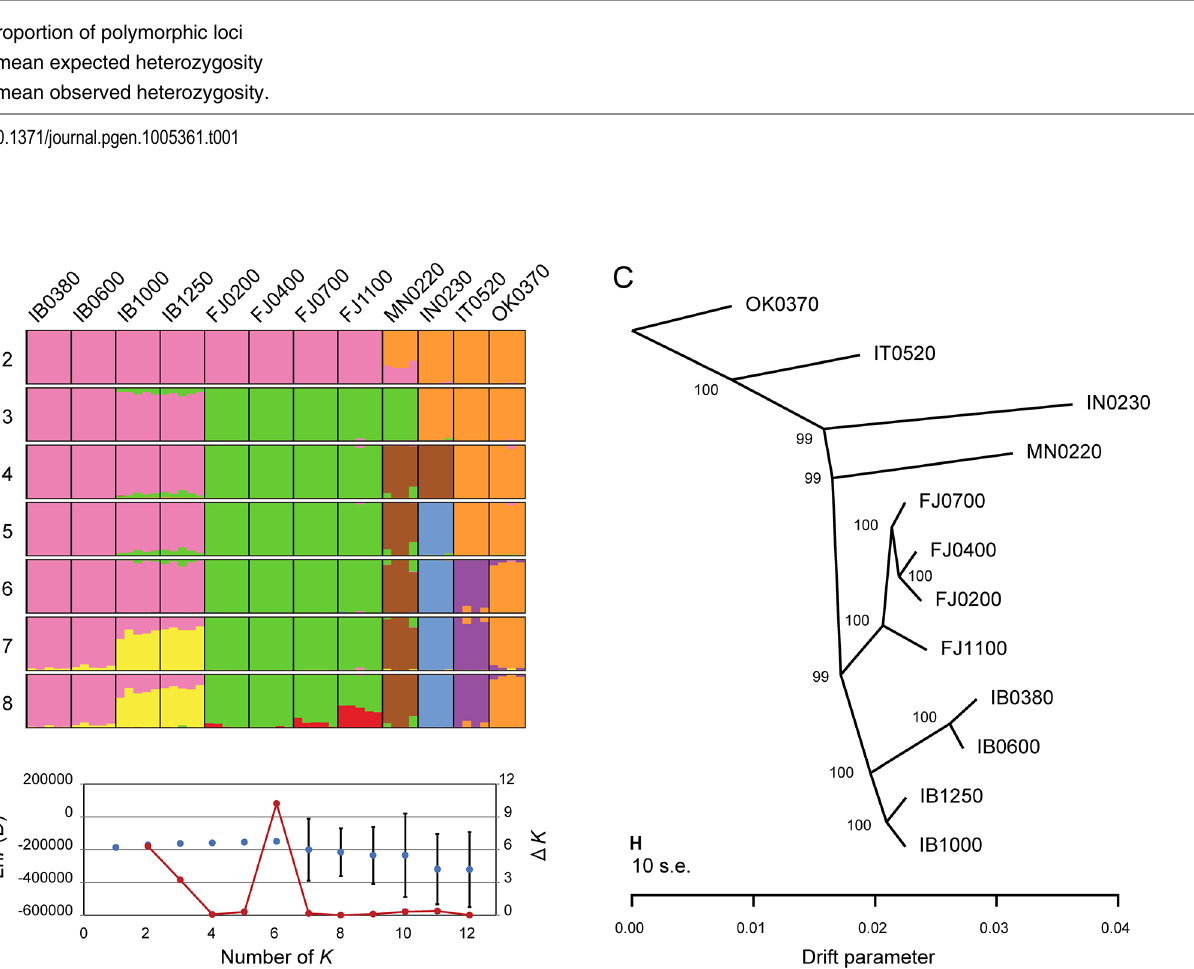
Fig 2. Genetic structures of the populations. (A) structure analysis with a K of 2 to 8 using all 56 individuals from the 12 populations. The result for each K is based on the simulation that provided the best Ln P (D) value (the log probability value) among 20 independent runs. Each bar represents an individual and the estimated membership in a particular genetic cluster. (B) Plotting of the mean Ln P (D) values from the structure analysis (blue dots) and Evanno ’ s Δ K (red dots). Error bars indicate the standard deviation of Ln P (D) values from the 20 independent runs. Both the maximum value of Ln P (D) and the peak position of Evanno ’ s Δ K are found at K = 6. (C) Maximum likelihood tree for the 12 populations obtained from TreeMix. The bootstrap supports for the nodes were calculated from 100 replicates. The scale bar represents 10 times the average standard error of the entries in the covariance matrix. Horizontal branch lengths are proportional to the amount of genetic drift. See S2 Fig for additional analysis within each